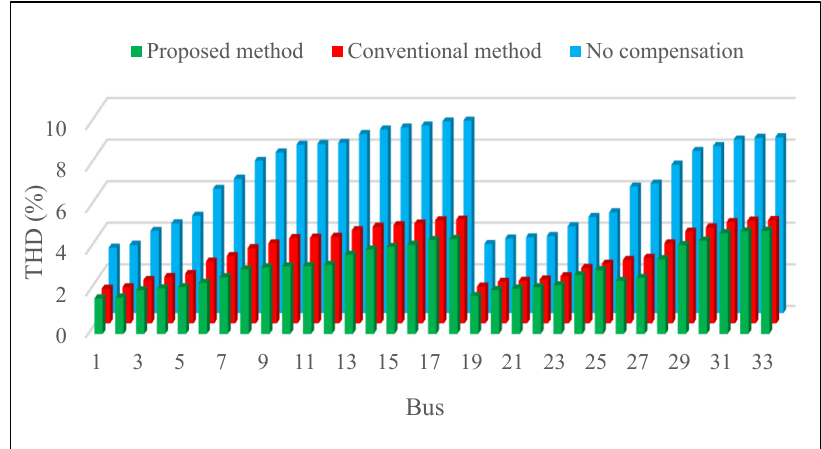
Figure 18. Voltage THD values before and after allocation of active filters.